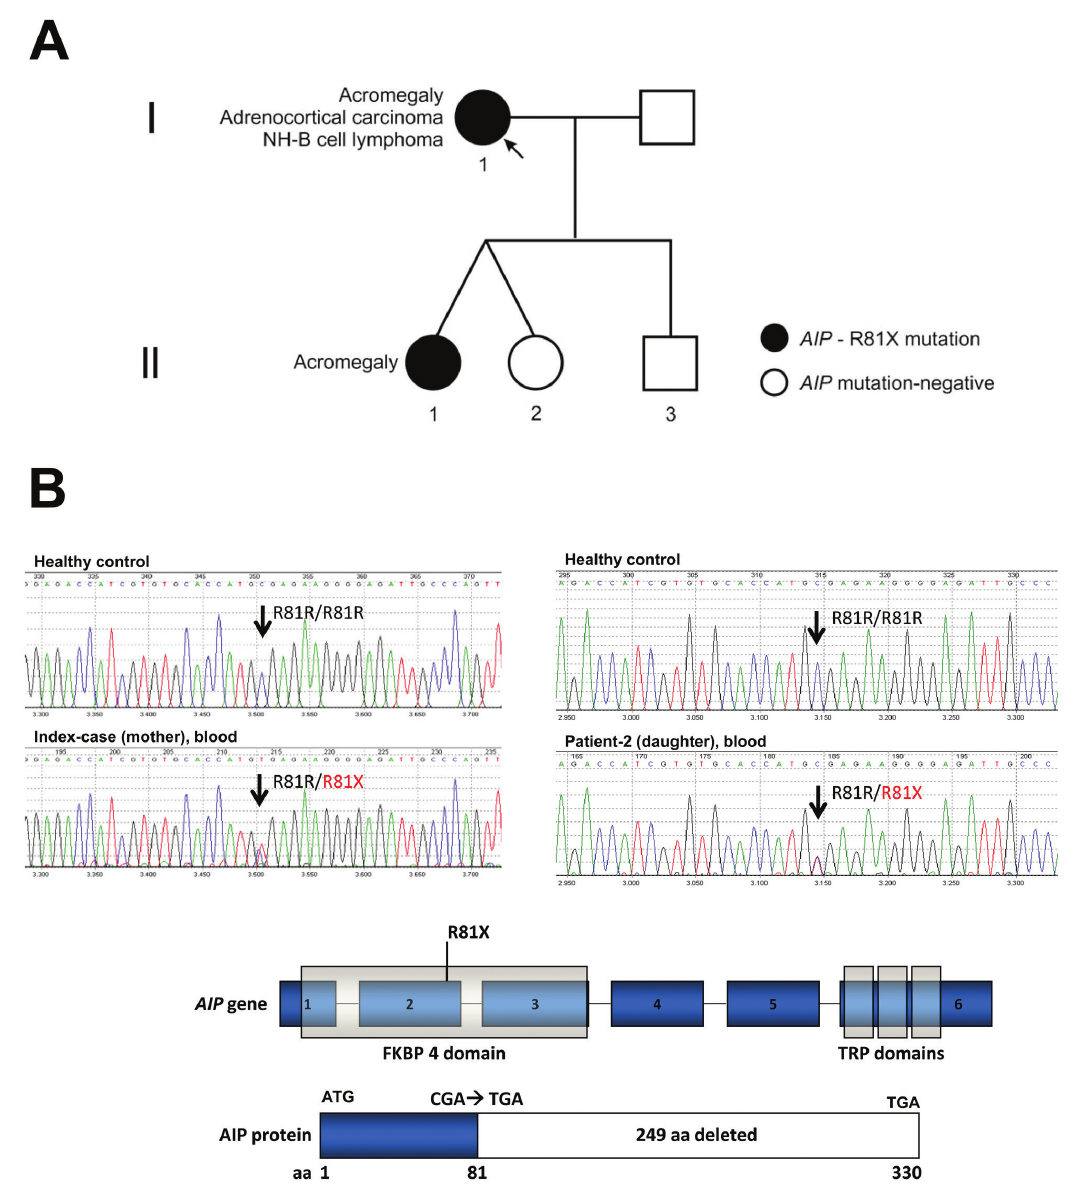
Figure 1 - Genealogy: identification of a functional AIP mutation that may disrupt the cAMP signaling pathway. A - The index patient developed acromegaly, adrenocortical carcinoma and B-cell lymphoma. One of her daughters had acromegaly due to a large and invasive somatotropinoma. B - The known AIP functional mutation c.241C>T (R81X) 28 was identified in genomic DNA samples from both patients (mother and daughter) with acromegaly but not in the three unaffected family